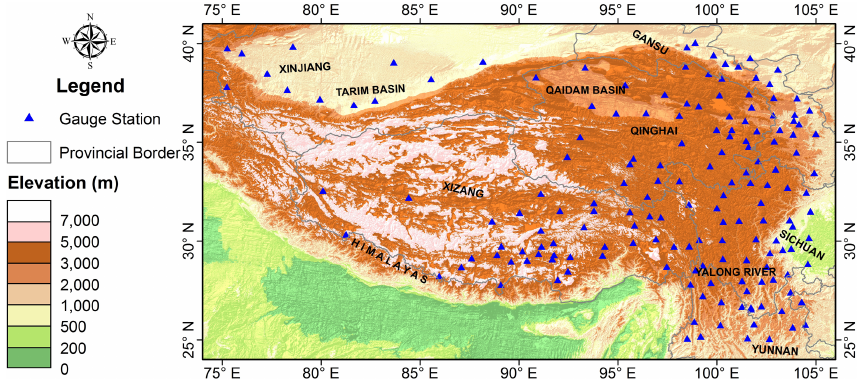
Fig. 1. The rain gauge network consisted of 166 stations used in our study, and the elevation pattern over the entire Tibetan Plateau and its peripheral regions.